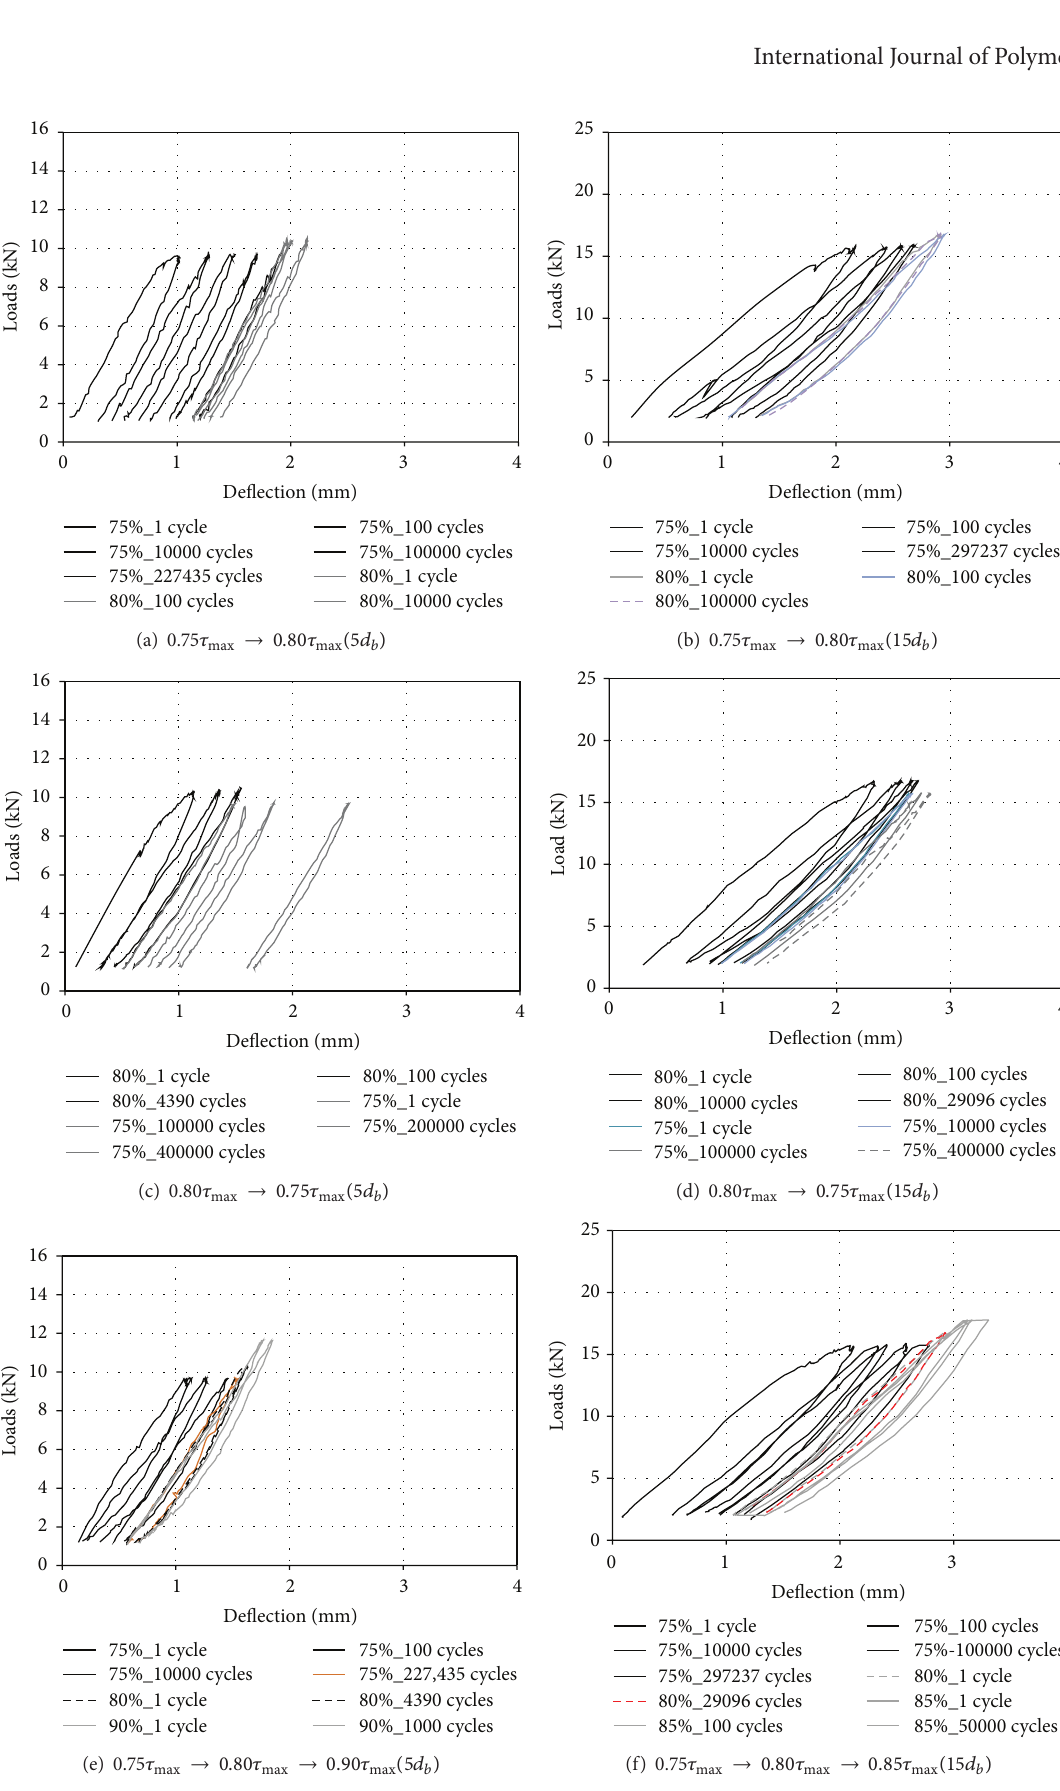
Figure 12: Relationship between applied loads and cumulative mid-deflection under various loading